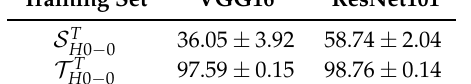
Table 3. Lower and upper bounds for traffic sign classification on T C deviation F1 scores for five training-testing runs are shown. The lower bound corresponds to training only with synthetic data ( S T ), while the upper bound corresponds to training with real data ( T T H 0 − 0